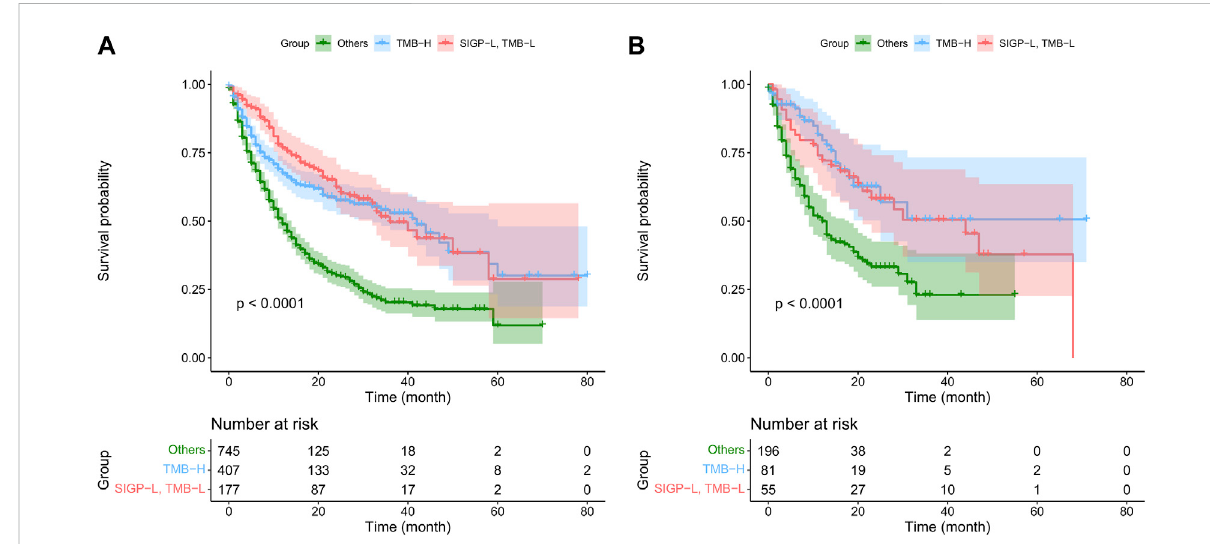
FIGURE 3 Kaplan – MeiercurvesofTMBcombinedwithSIGP(threegroups)inMSK-TMB-trainingandMSK-TMB-test. (A) KMcurvesofSIGP+TMBinMSK- TMB-training; (B) KM curves of SIGP + TMB in